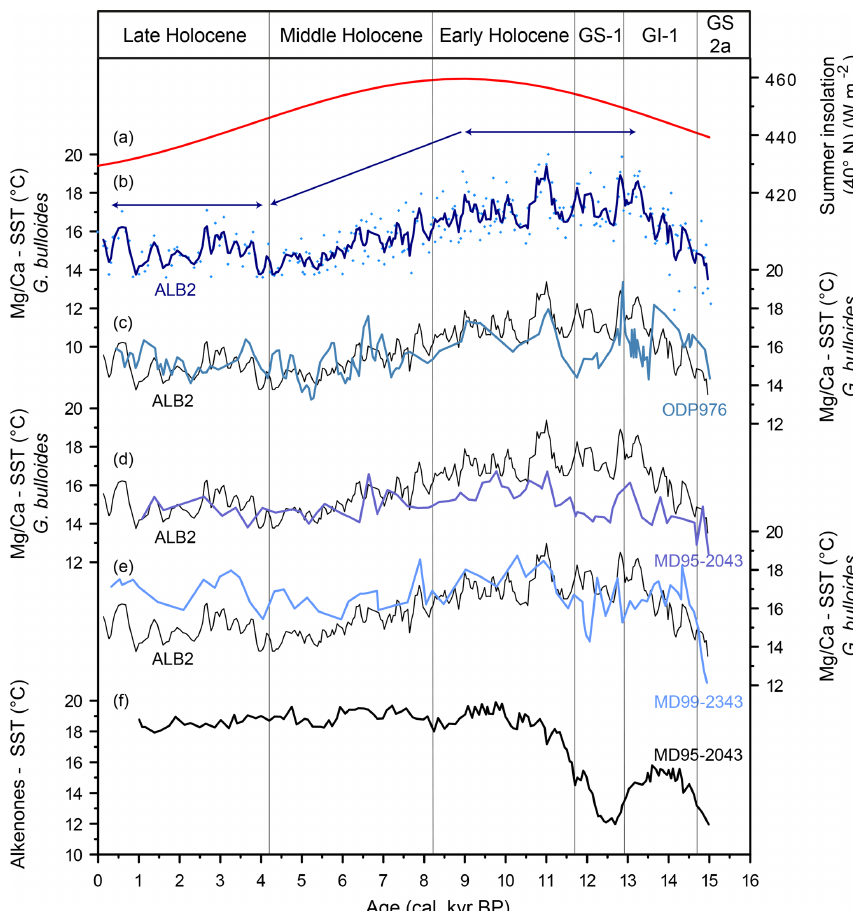
Figure 3. Western Mediterranean SST multi-record comparison for the last 16cal.kyrBP. (a) In red, summer insolation at 40 ◦ N; (b) Mg / Ca SST ( ◦ C) from the ALB-2. Light-blue dots correspond to each SST result; the three-point average is shown by the bold dark-blue line. Dark-blue arrows above the record correspond to the three Holocene intervals described in the text (c, d, e) : Mg / Ca SST ( ◦ C) from ODP976 (Jiménez-Amat and Zahn, 2015), MD95-2043, and MD99-2343, respectively (bold blue lines), compared with the ALB-2 three-point average Mg / Ca SST ( ◦ C) (black line underneath). Note that both records from each plot are plotted on the same y axis. (f) Alkenone SST ( ◦ C) from MD95-2043 (Cacho et al.,